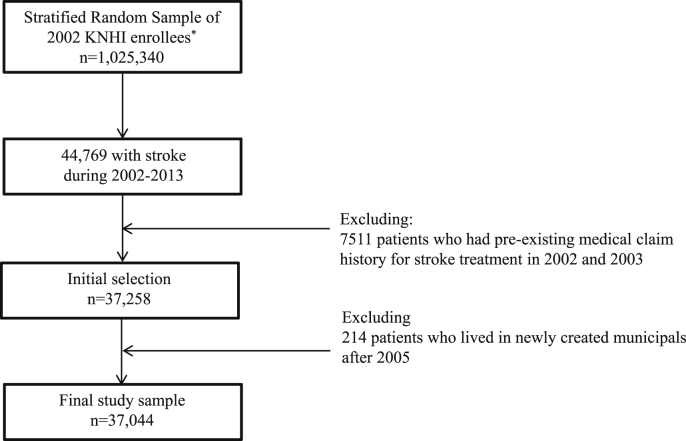
Study flow diagram.